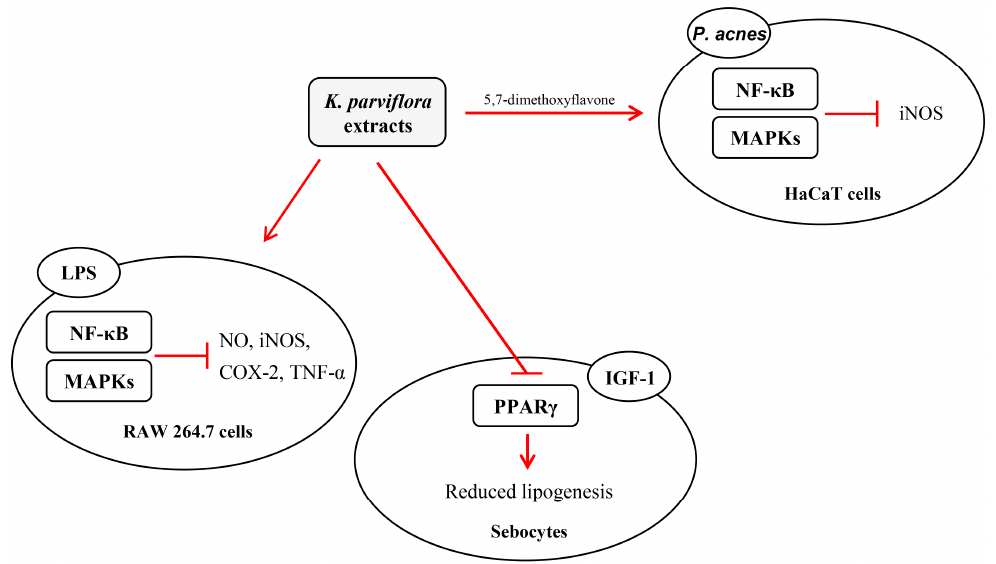
Figure 7. Proposed underlying mechanism of the anti-acne effect of Kaempferia parviflora. The t-bar denotes an inhibitory effect.